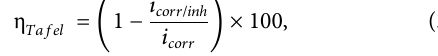
Frontiers in Chemistry |